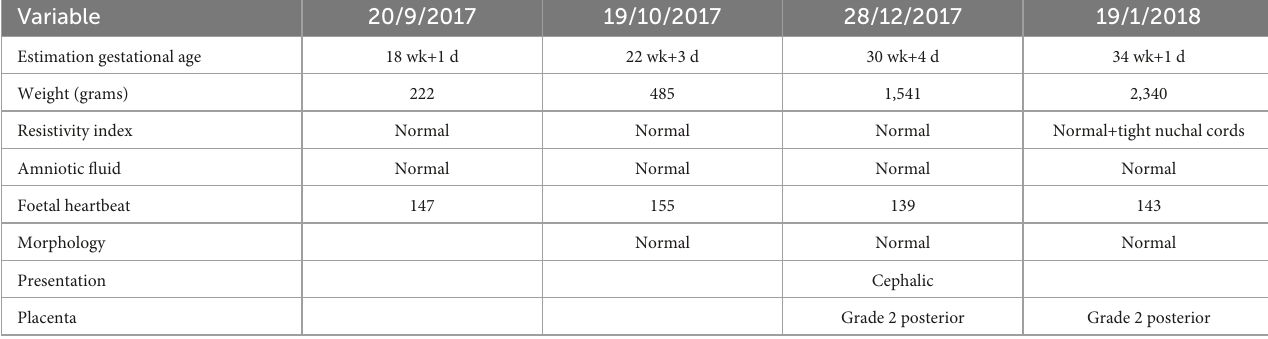
TABLE 2 Ultrasound follow-up of the